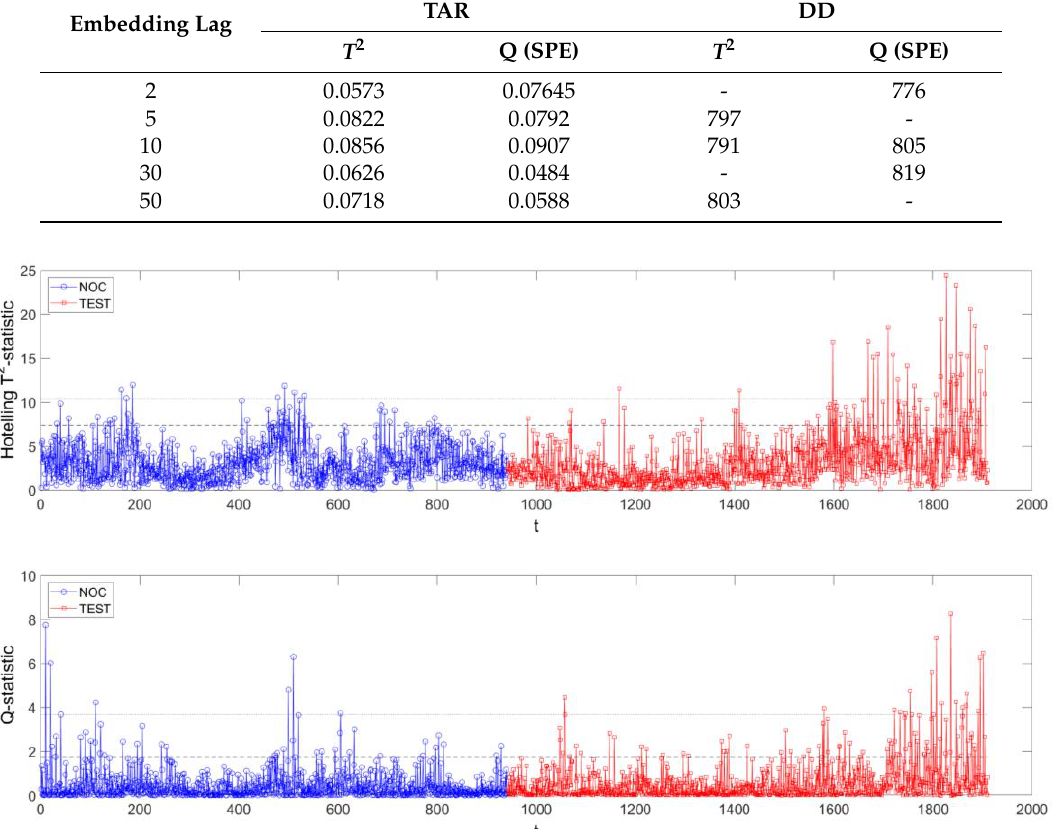
Figure 21. T 2 ( top ) and Q ( bottom ) process monitoring charts of simulated dataset using Method III, with embedding dimension of four and embedding lag of 10. NOC data are shown in blue and test (fault) data in red.